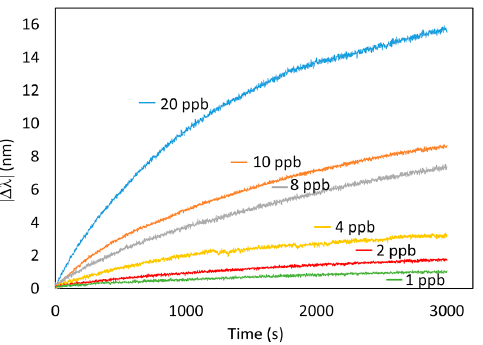
Figure 5. Dynamic response of the sensors to different Hg concentration, ranging from 20 ppb to 1 ppb.